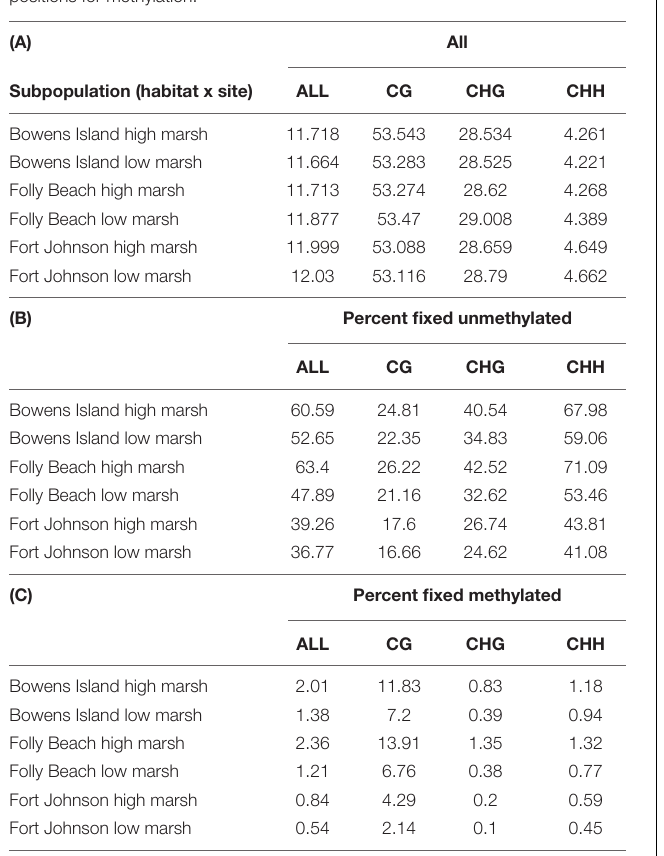
TABLE 3 | Proportions of (A) methylated cytosines per context and for all contexts, (B) fixed cytosine positions for no methylation, and (C) fixed cytosine positions for methylation.